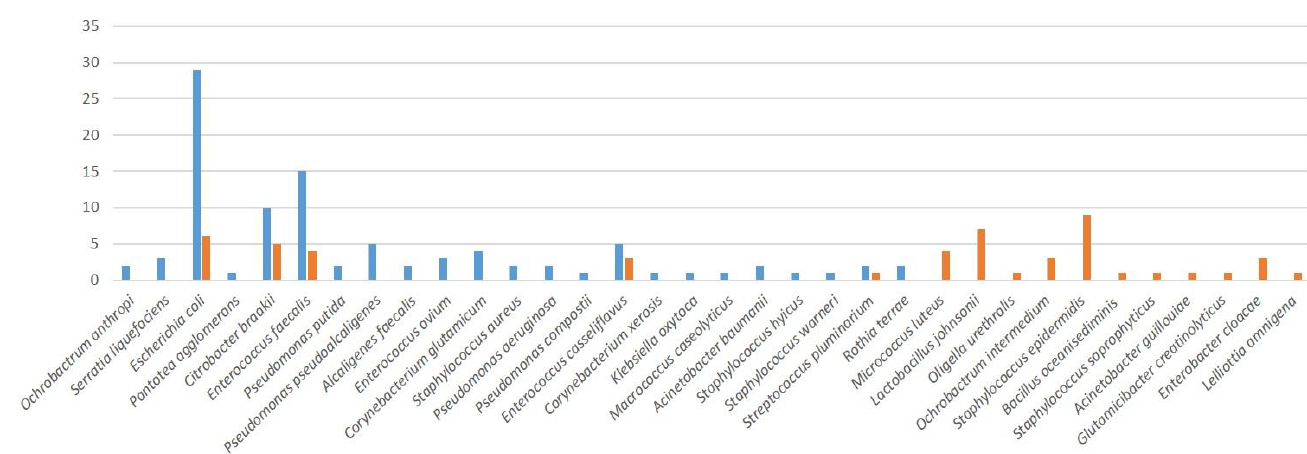
Figure 3. Distribution of identified bacterial species between the analyzed breeds.